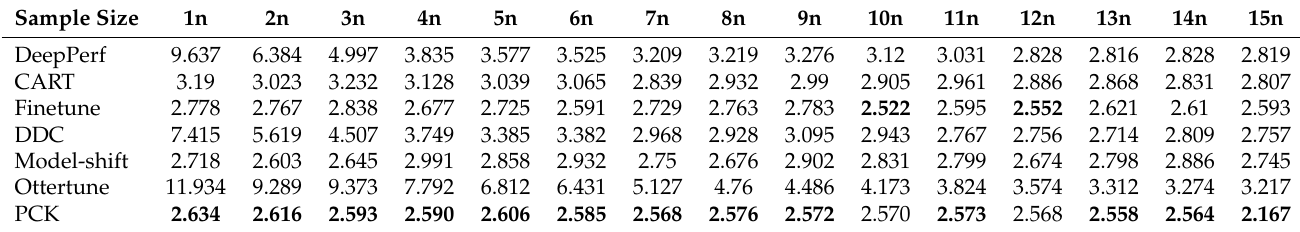
Table 3. MRE comparison among different approaches for PostgreSQL (version 9.3–11.0).